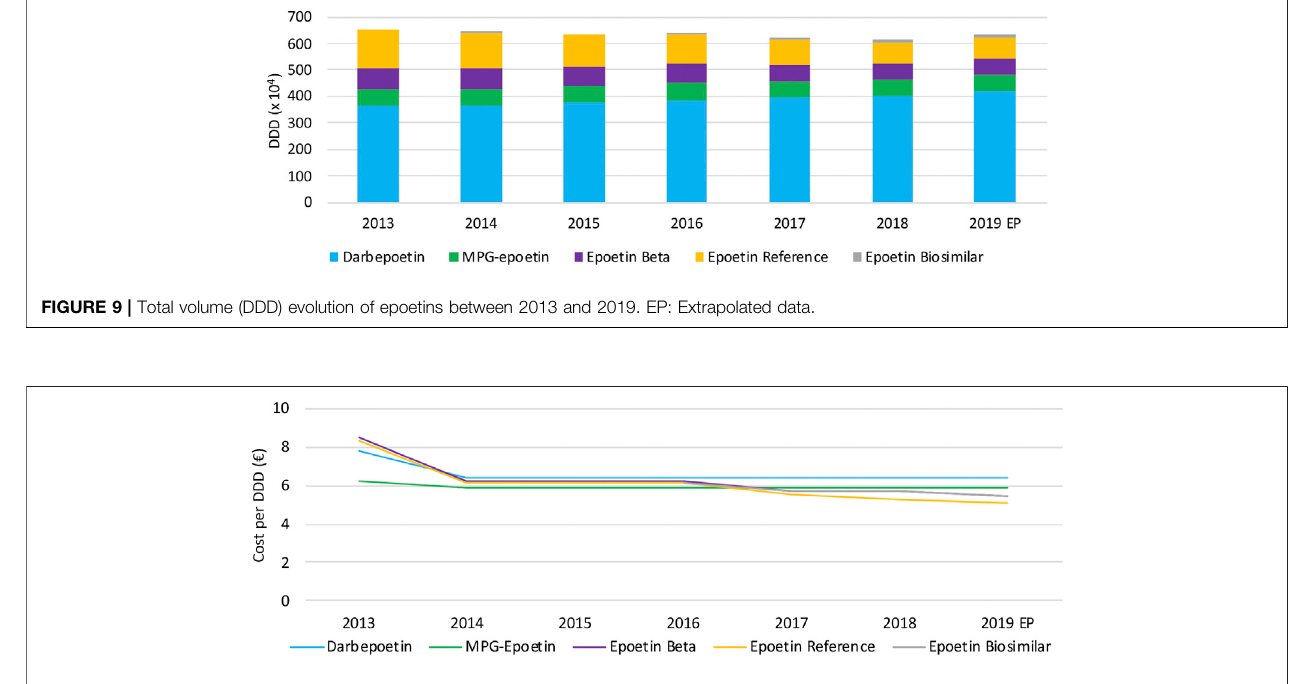
FIGURE 10 | Daily cost ( € per DDD) evolution of epoetins between 2013 and 2019. EP: Extrapolated